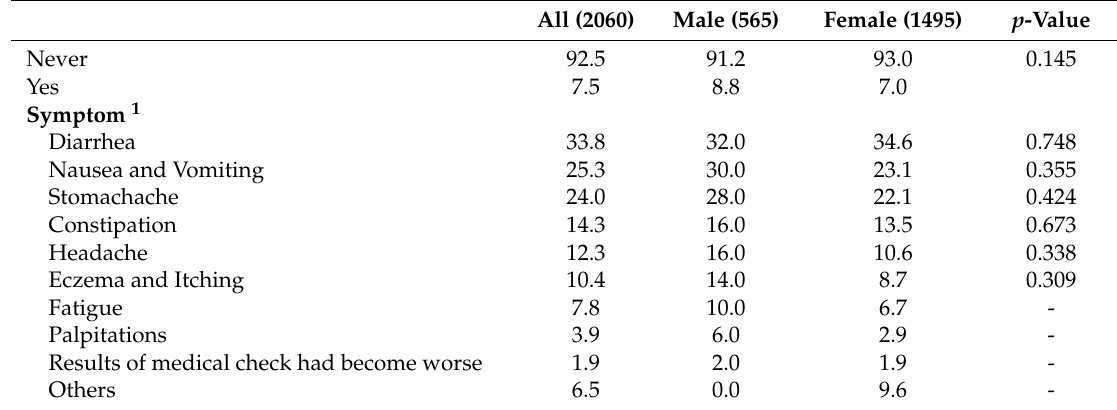
Table 7. Have you ever experienced adverse effects due to dietary supplement use? If yes, what symptom(s) did you experience? (%).